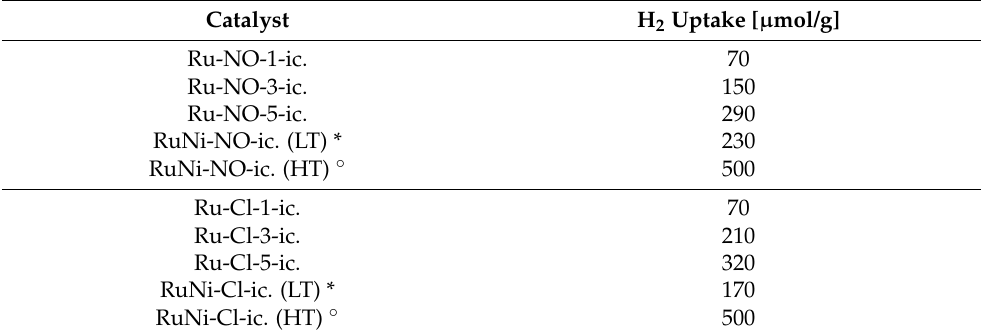
Table 5. H 2 uptake calculated from TPR profiles for the Ru- and Ru/Ni on Al 2 O 3 catalysts.